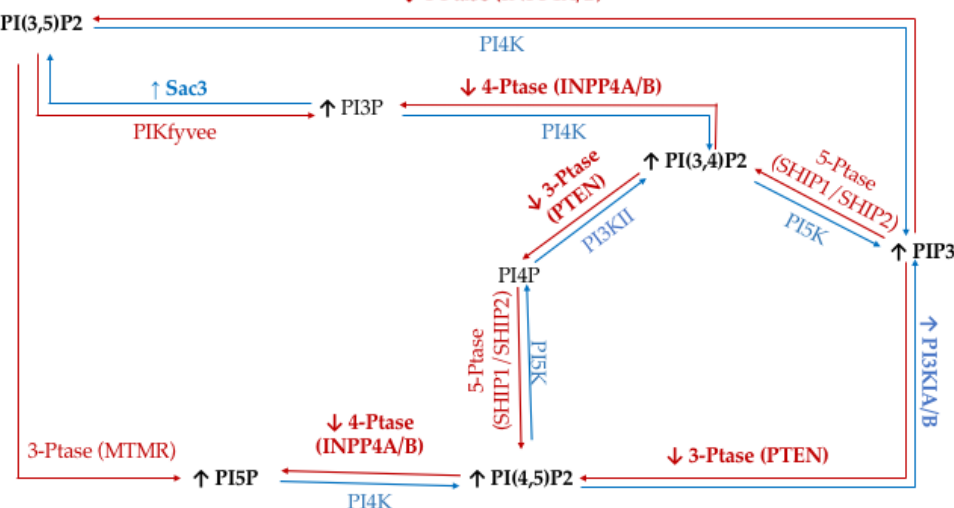
Figure 9. Triple Negative Breast Cancer (TNBC) related expression of PI kinases and phosphatases. Graphical representation of the cancer specific overexpression / increased activity ( ↑ ) and decreased expression / activity ( ↓ ) of the kinases (blue), phosphatases (red), as well as the hypothesized effects on the resulting lipidome have been noted.